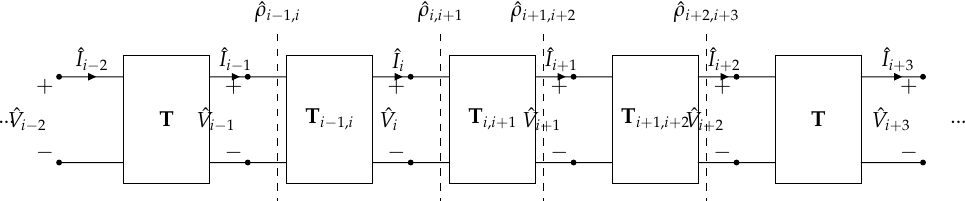
Figure 10. Section of the equivalent TL of a resonator array with a receiver coupled with the i th and ( i + 1 ) th